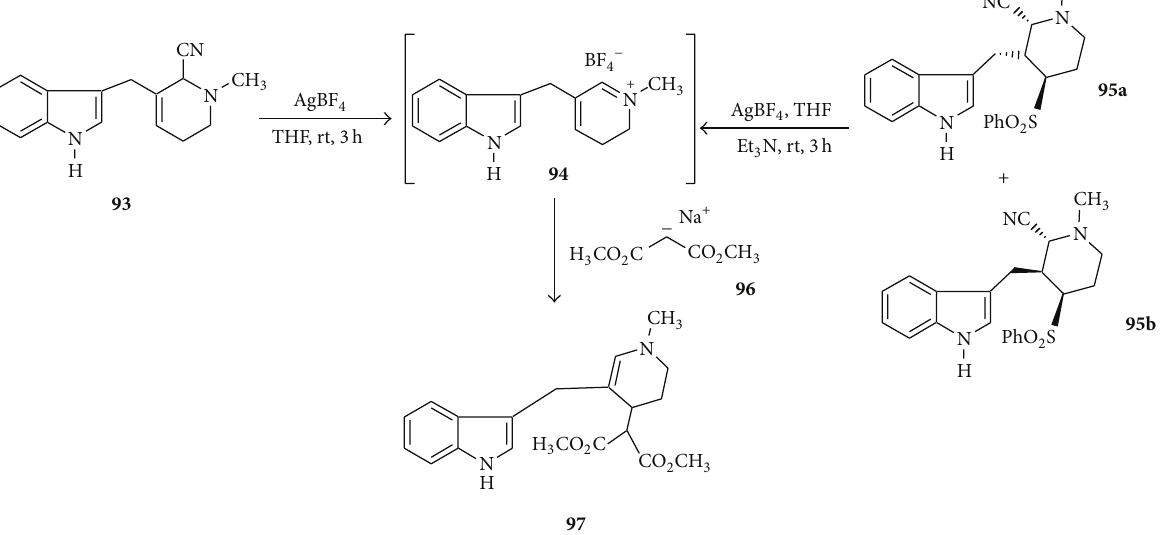
Scheme 19: AgBF 4 -mediated synthesis of C-7 indole-substituted